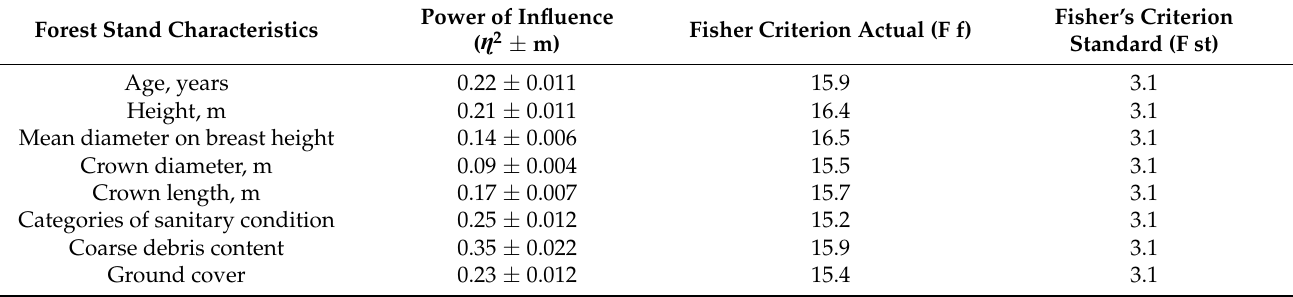
Table 8. Influence of forest stand characteristics on burning index. Forest Stand